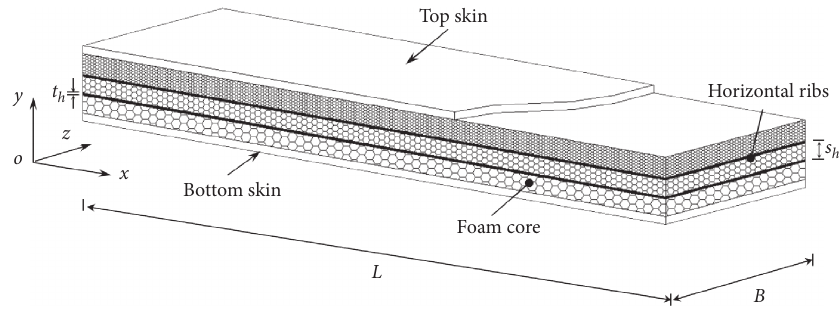
Figure 1: Proposed design of the GHP panel.